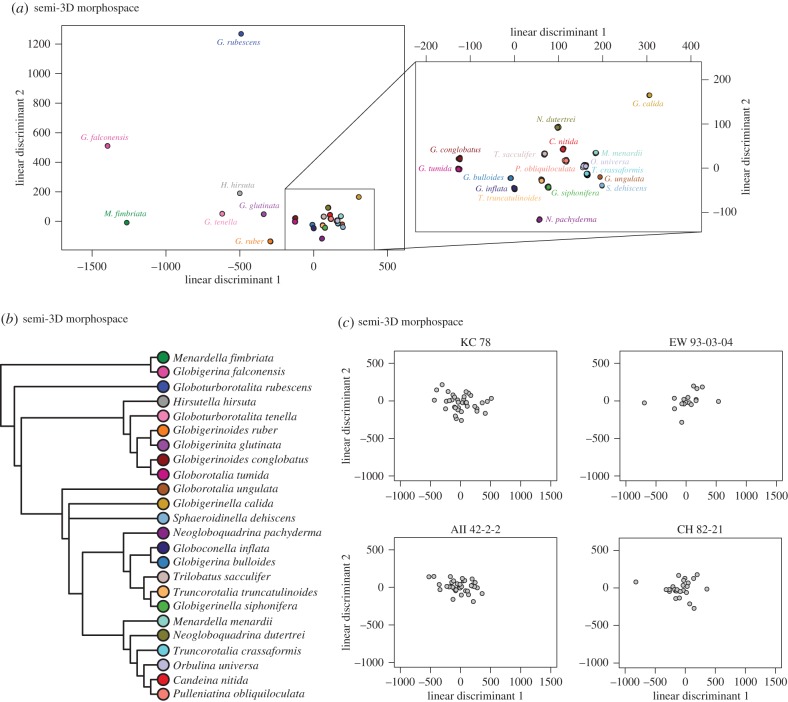
(a) Plot of the linear discriminant (LD) space (LD1 versus LD2) for the 24 planktonic foraminifer species present in the semi-3D dataset. Zoomed-in box shows the enclosed species on different axes to show relative cluster positions more clearly. (b) Corresponding majority-rule consensus cluster dendrogram for the LD space shown in (a). (c) LD spaces for coretop individuals, with species identity predicted using the LD model estimated using the species-identified individuals in (a) as the training set. Each coretop is plotted with identical axes to show relative occupation.